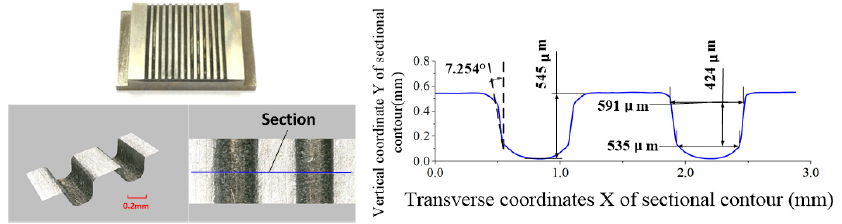
Figure 12. Front and rear edge equal-width cathode machining group groove specimens.